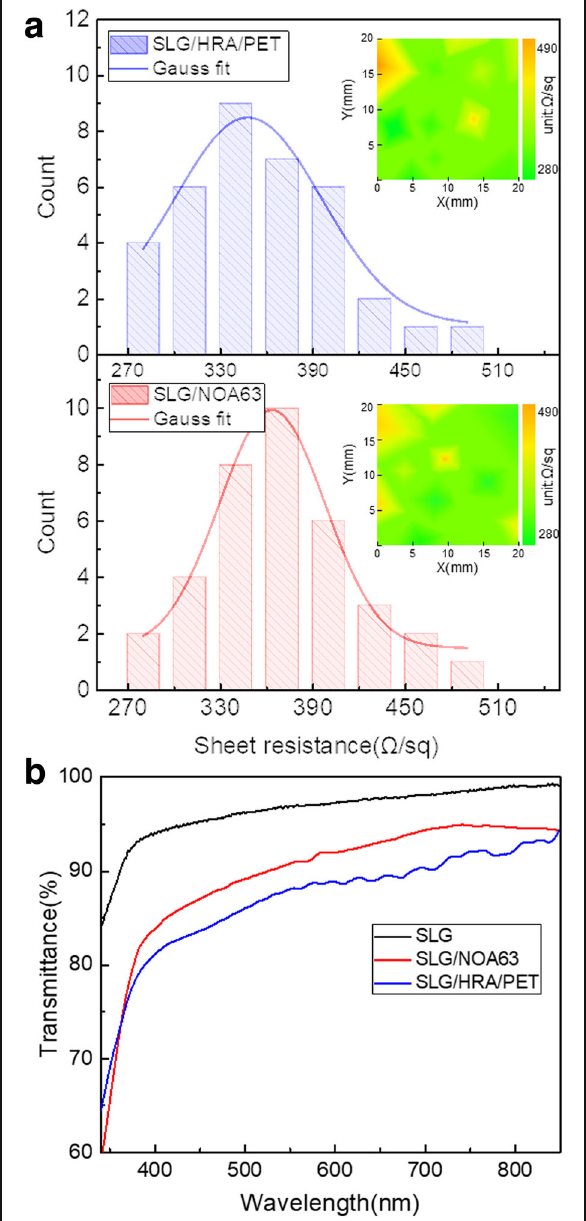
Fig. 4 a Histogram and spatial distribution of sheet resistance of the SLG samples on HRA/PET and NOA63 (size 20 mm × 20 mm). b Transmittance of SLG, SLG/HRA/PET, and SLG/NOA63 in visible region; the thickness of HRA/PET and NOA63 are both about 150 μ